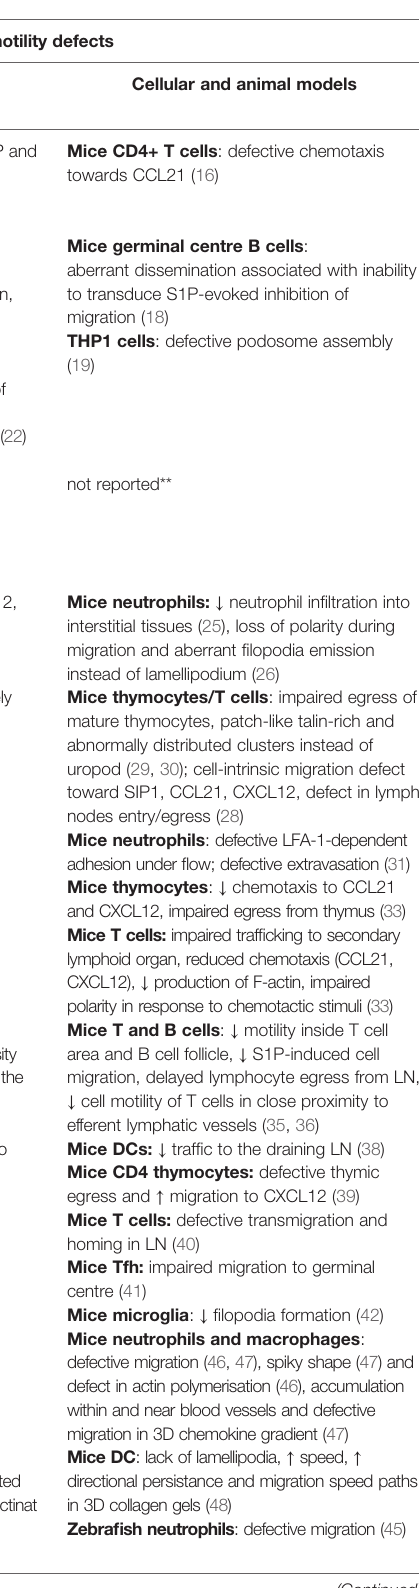
TABLE 1 | Actin-related inborn errors of immunity and associated leukocyte motility